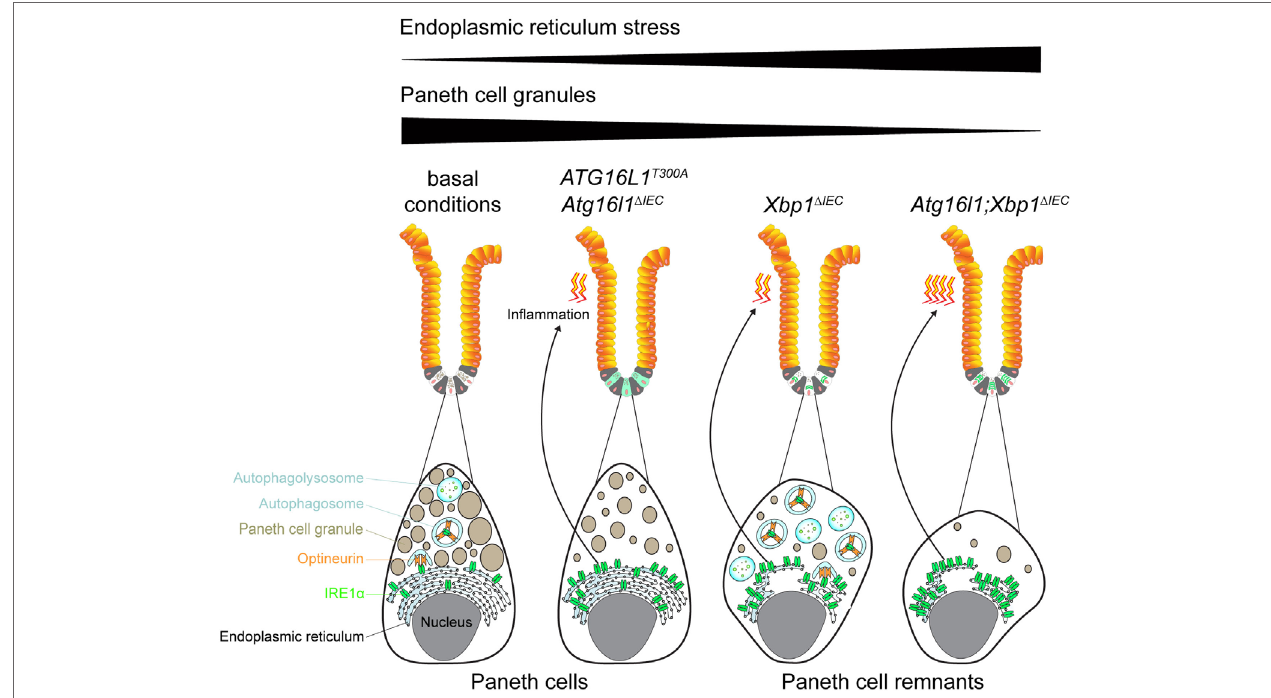
FiGURe 1 | Optineurin (OPTN)-dependent degradation of inositol-requiring enzyme 1 α (IRE1 α ) is abolished in autophagy-deficient Paneth cells resulting in a Crohn’s disease (CD)-like inflammation. Under basal conditions, the endoplasmic reticulum (ER) stress sensor IRE1 α is recognized by the selective autophagy receptor OPTN and is subsequently engulfed by the autophagosomal membrane and targeted for degradation in the autophagolysosome. In individuals harboring a homozygous ATG16L1 T300A mutation or in mice with an Atg16l1 deletion in the intestinal epithelium ( Atg16l1 Δ IEC ), autophagosomes cannot be formed and hence display hypomorphic autophagy. As a result of the defective autophagy as well as a decreased capacity of the unfolded protein response (UPR) with age, ER stress, and IRE1 α are accumulating in Paneth cells, which concomitantly leads to the development of a CD-like inflammation in the ileum when mice become older. ATG16L1 is also involved in Paneth cell granule exocytosis and hence integrity is disturbed in ATG16L1-deficient individuals. Mice with a deletion of the UPR transcription factor Xbp1 in the intestinal epithelium ( Xbp1 Δ IEC ) also exhibit elevated levels of ER stress and IRE1 α , but which are counteracted by increased formation of autophagosomes and OPTN-mediated degradation of IRE1 α . In Atg16l1;Xbp1 Δ IEC mice in which both compensatory mechanisms (UPR and autophagy) fail, unrestrained IRE1 α leads to the development of a CD-like inflammation similar to the Atg16l1 Δ IEC mice, but earlier in life. Due to prolonged ER stress Paneth cell integrity in Xbp1 Δ IEC and Atg16l1;Xbp1 Δ IEC mice is massively disturbed lacking an expansion of the ER and lacking lysozyme expression due to minuscule Paneth cell